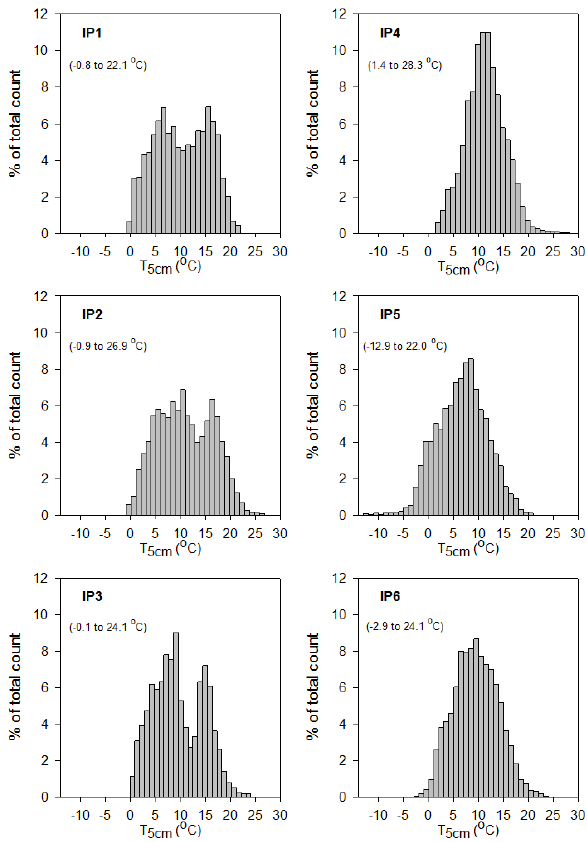
Figure 2. Frequency distribution of soil temperature at 5cm depth ( T 5cm ) at sites IP1–6 shown as a percentage (%) of total count. Measured temperature range ( ◦ C) at each site shown in